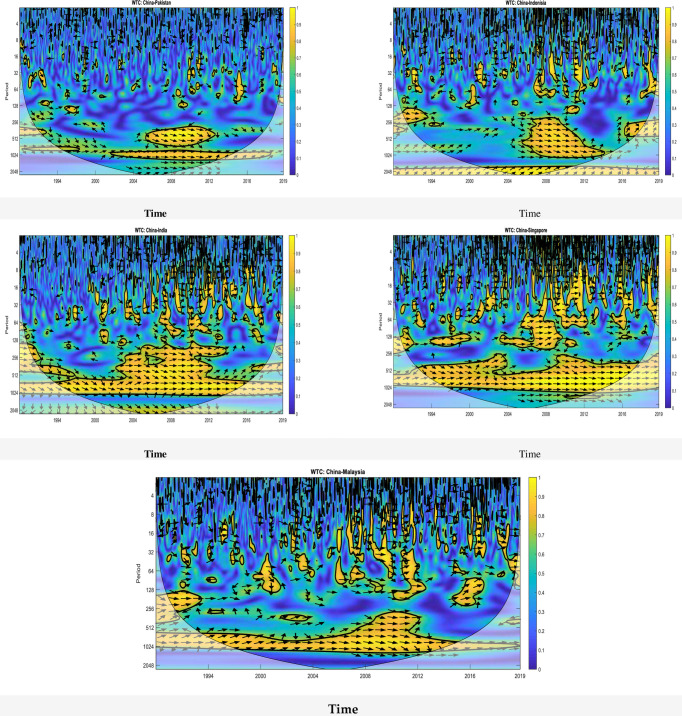
Wavelet coherence of the emerging stock market.The tick black contour encloses regions where the wavelet coherence is significant at the 5% level against the red noise estimated from Monte Carlo simulations using phase randomized surrogate series. The cone of influence (COI) is indicated by the lighter shade which delimits the important power regions. The arrows indicate the phase difference between the two time series. The direction of arrows captures the phase difference between two time series. Arrows pointed to the right (left) indicate that variables are in phase (out of phase), to the right and up (down), the first variable is leading (lagging), and to the left and up (down), the first variable is lagging (leading). Time (year) and frequency (period) are represented on the horizontal and the vertical axis, respectively. The readers can refer to the web version of this article for an accurate interpretation of the graphs.